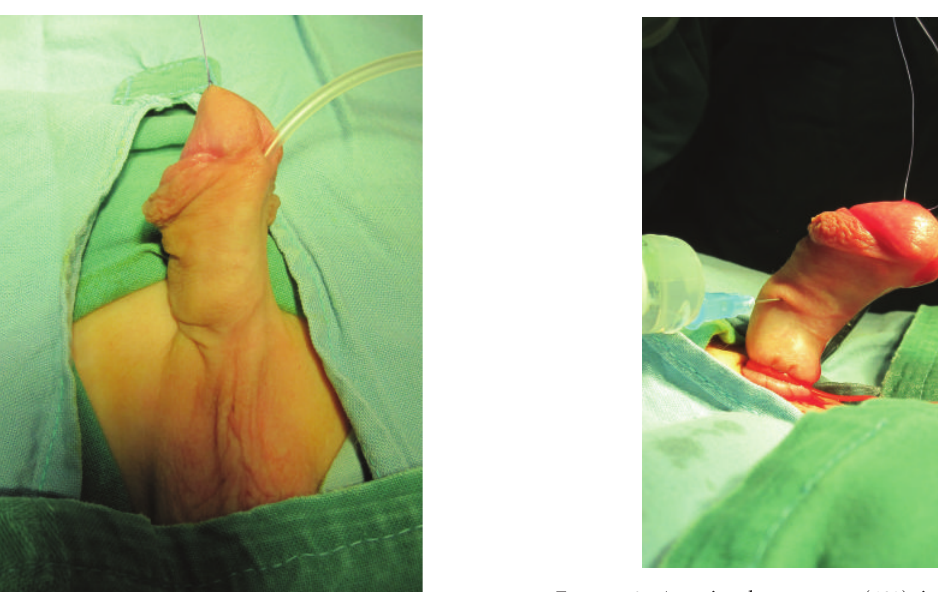
Figure 2: Associated curvature (40 ◦ ) is confirmed by artificial